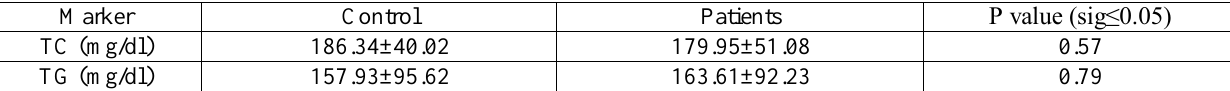
Table 7: Total cholesterol and triglyceride levels in patients and control